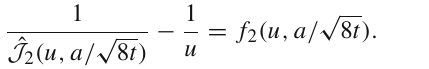
Fig. 3 Cutoff effects in the usual step scaling function ( ˆ C 0 ( a / compared to those in J 1 (see ˆ C 1 ( a / See text for more details. Here we show the case of the Zeuthen flow/improved observable with plaquette gauge action (i.e. the